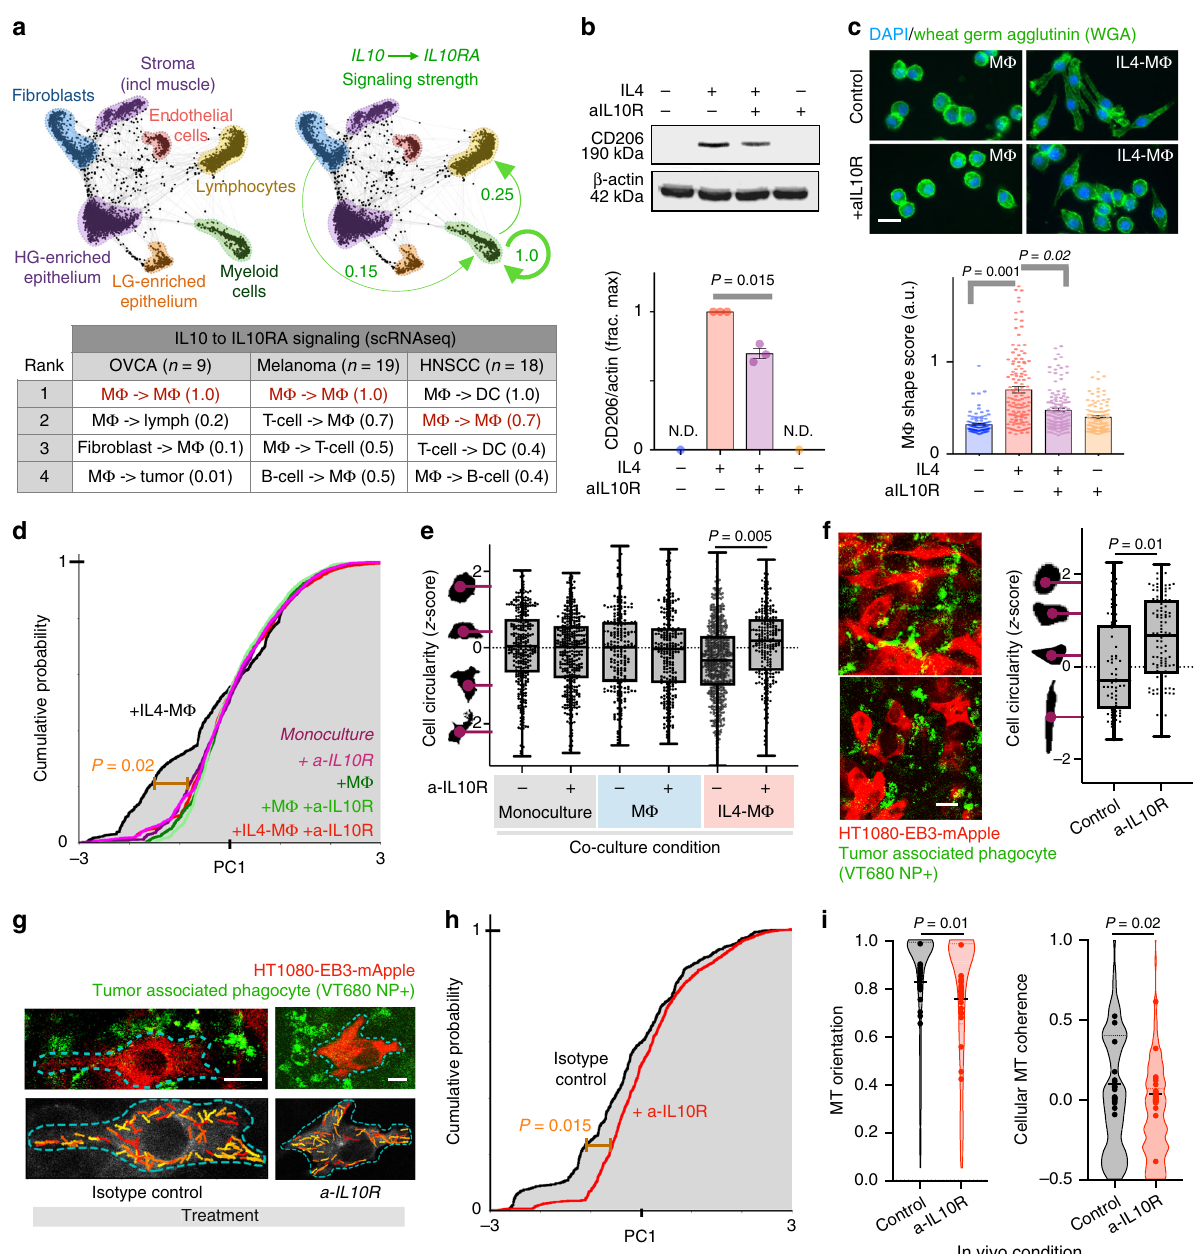
Fig. 9 Anti-IL10R antibody shifts M Φ polarization and reduces tumor cell MT coherence. a SPRING visualizes scRNAseq data by cell-type from 9 patient biopsies, most either high-grade (HG) or low-grade (LG) serous OVCA ( n > 2,900 total cells). Arrows and table report top values for [IL10xIL10RA] (fraction max) from published patient cohorts 68 – 70 . b CD206 western blot and densitometry 24 h following aIL10R in RAW264.7 (*two-tailed t test; n = 3; mean ± s.e.m.). c IL4-induced elongation in M Φ shape (calculated from combined shape features; scale bar = 10 μ m), was monitored 24 h post-aIL10R (*two-tailed t test; n = 100 RAW264.7 cells per group with 4 groups; means ± s.e.m.). HT1080 MT dynamics ( d ) and cell circularity ( e ) were quanti fi ed as in Fig. 5, 4 h following treatment with aIL10R ( d : *two-tailed permutation test; n = 21,218 tracks from 99 total cells; e *two-tailed t test; n = 1,964 total cells). f Representative IVM of TAM-proximal HT1080 following 48 h treatment with aIL10R (bottom left) or the isotype control (top left), in dorsal window chamber of nu/nu subjects, and corresponding HT1080 circularity (right; *two-tailed t test on cell data; n = 177 total cells; scale bar = 25 μ m). g – i MT dynamics were captured from ( f ) and analyzed as in ( d ) (*two-tailed permutation test; n = 2454 tracks and 51 total cells across n = 8 tumors; bars denote mean; scale bar, 10 μ m). All box plots are min, 25%tile, median, 75%tile, and max. Source data are provided as a source data fi